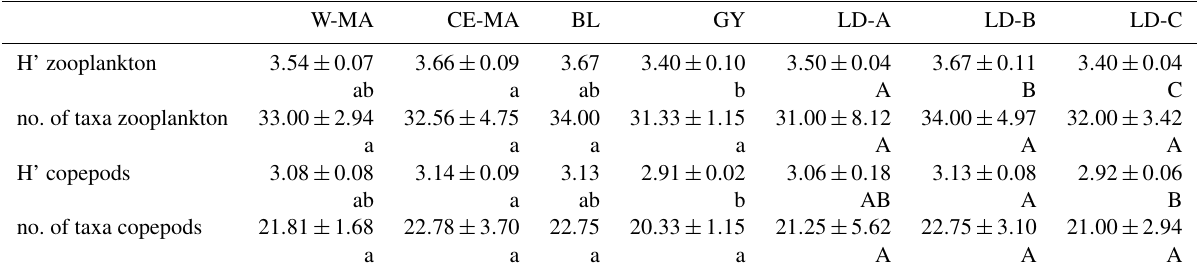
Table 4. Mean values ( ± standard deviation) per region of taxonomic diversity (H’: Shannon index) and taxonomic richness (no. of taxa per Melanesian archipelago; BL: station B, blooming conditions; GY: subtropical gyre. Letters below the mean values indicate homogeneous groups between zones (small letters) or LD stations (capital letters) according to post hoc Scheffé